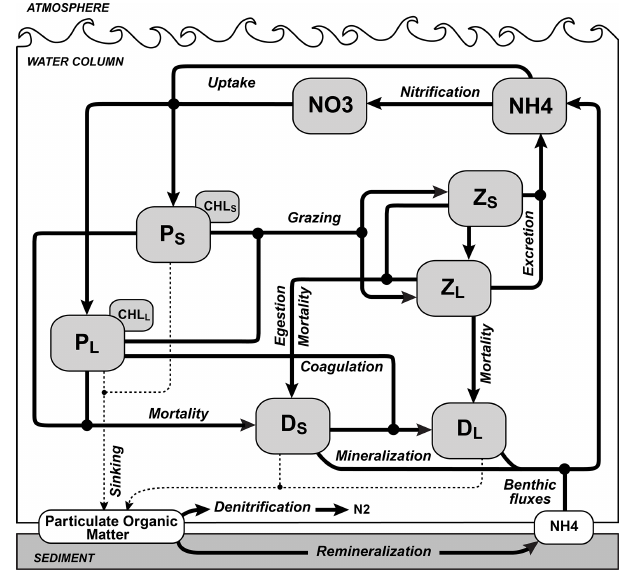
Figure 2. Schematic of the biogeochemical model used in ROMS. The state variables are small phytoplankton ( P S ) and chlorophyll (Chl S ), large phytoplankton ( P L ) and chlorophyll (Chl L ), small zooplankton ( Z S ), large zooplankton ( Z L ), slow-sinking small de- tritus ( D S ), fast-sinking large detritus ( D L ), nitrate (NO 3 ) and am- monium (NH 4 ). Dashed lines indicate sinking. Black dots represent the connections between